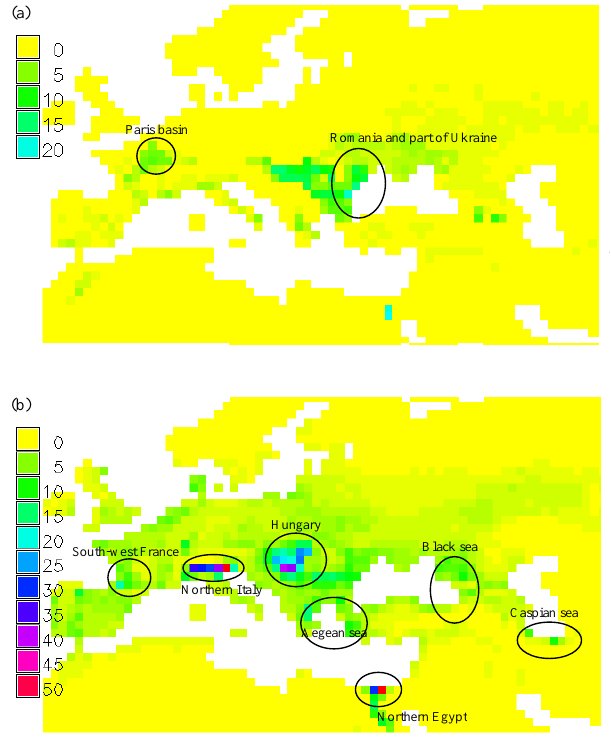
Fig. 11. Fraction (%) of C4 plants at 1 ◦ resolution: (a) ISLSCP-II, Figure 11. Fraction (%) of C4 plants at 1° resolution: 17 (b)